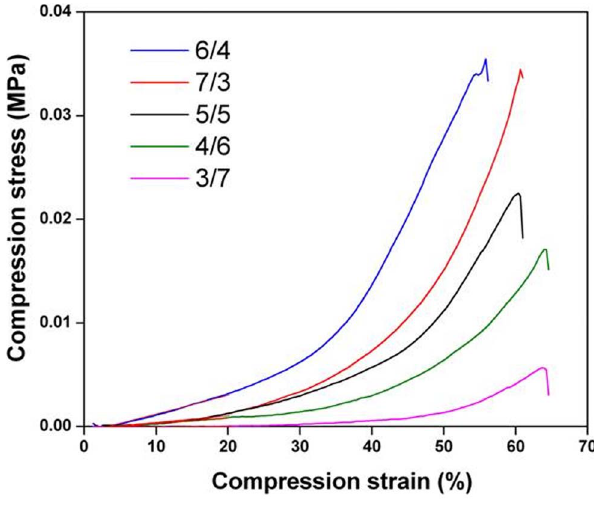
Figure 8. Stress-strain curves for all the compositions of dextran/gelatin